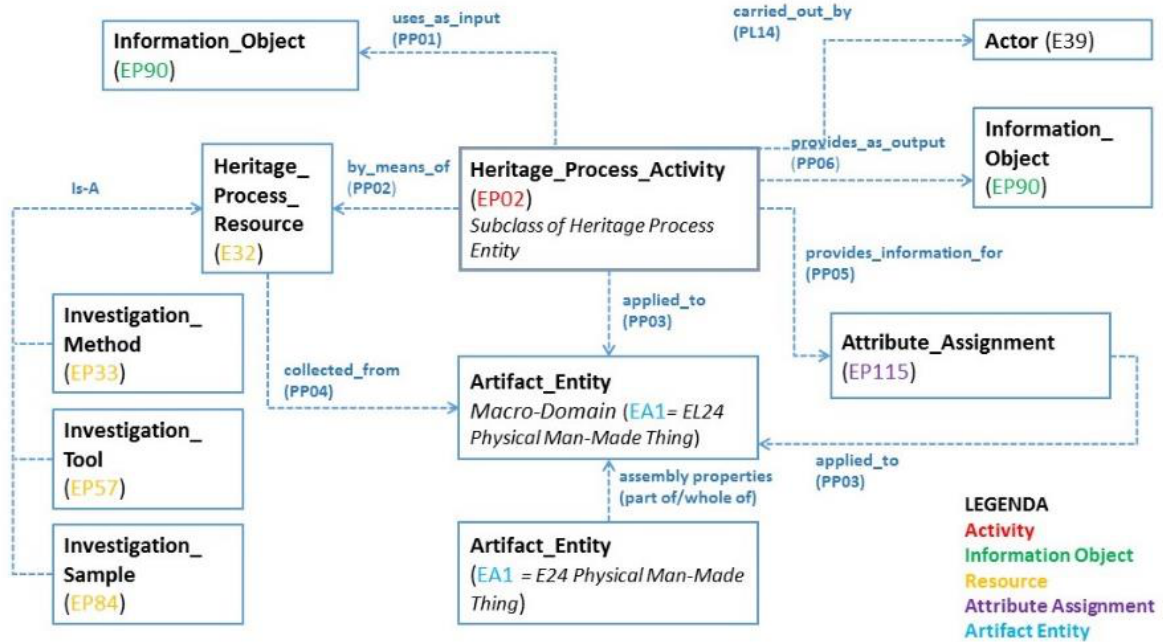
Figure 2. Heritage process: investigation